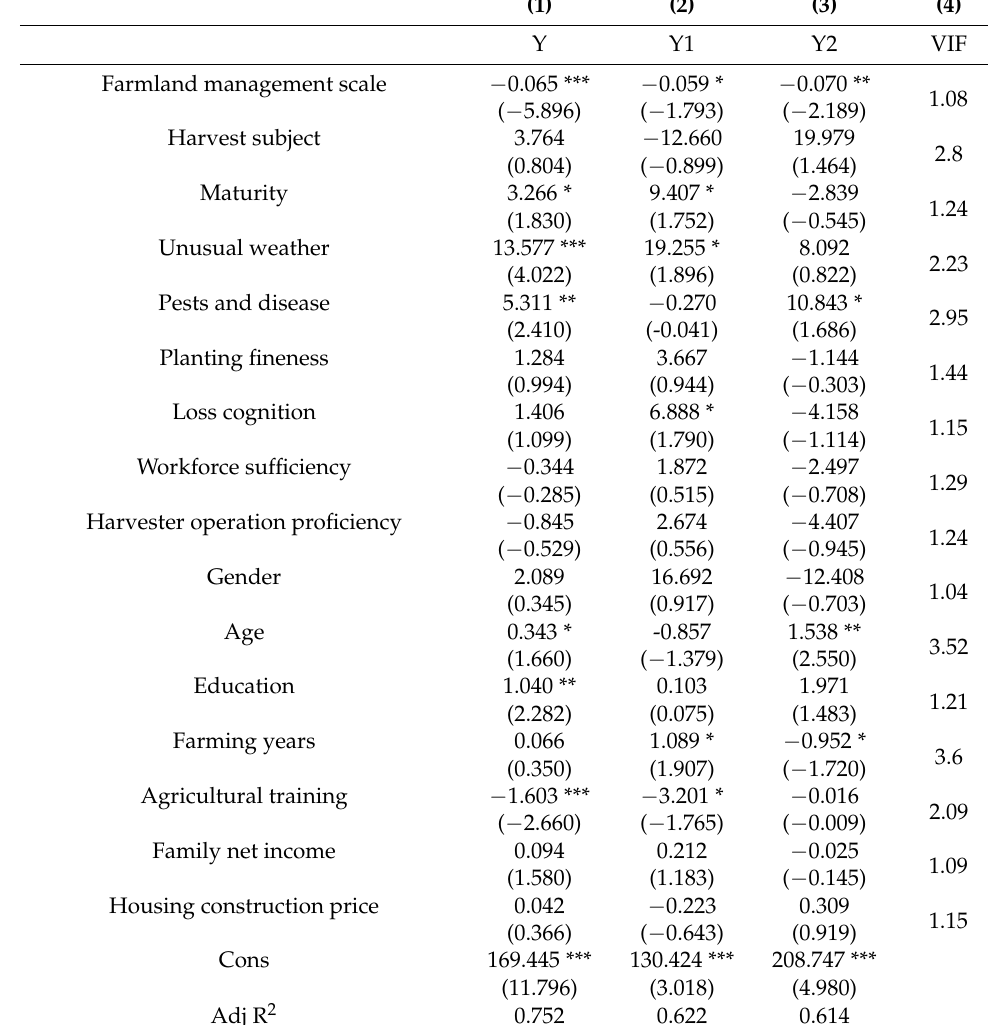
Table 3. Regression results of farmland operation scale on grain loss